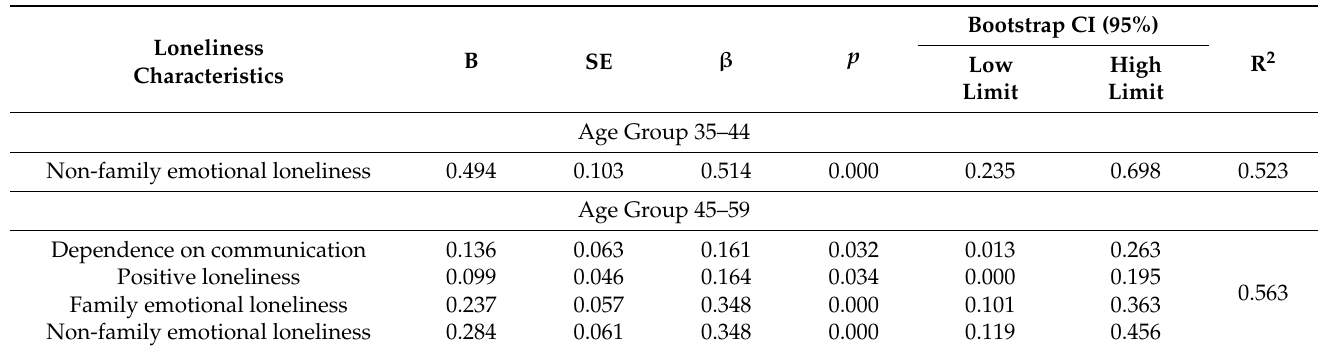
Table 4. Regression analysis of the loneliness variables in age groups in pandemic